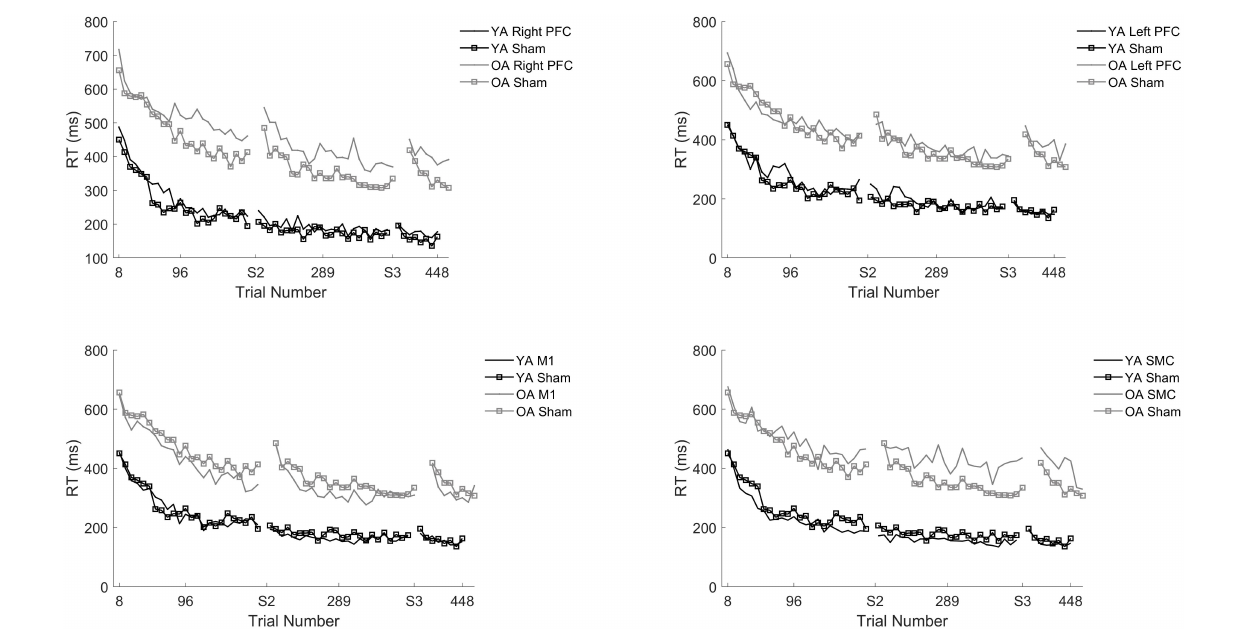
FIGURE 3 | Reaction time (RT) for young and older adults as a function of trial number. RT was binned across every eight trials. Each panel represents a tDCS stimulation location and sham group for reference. (Top left) Young (black) and older (gray) adults in the right prefrontal cortex (PFC) tDCS groups as well as young (black with squares) and older (gray with squares) sham groups. (Top right) Young (black) and older (gray) adults in the left PFC tDCS groups as well as sham (squares). (Bottom left) Young (black) and older (gray) adults primary motor cortex (M1) tDCS groups. (Bottom right) Young (black) and older (gray) adults in the supplementary motor complex (SMC) tDCS groups.